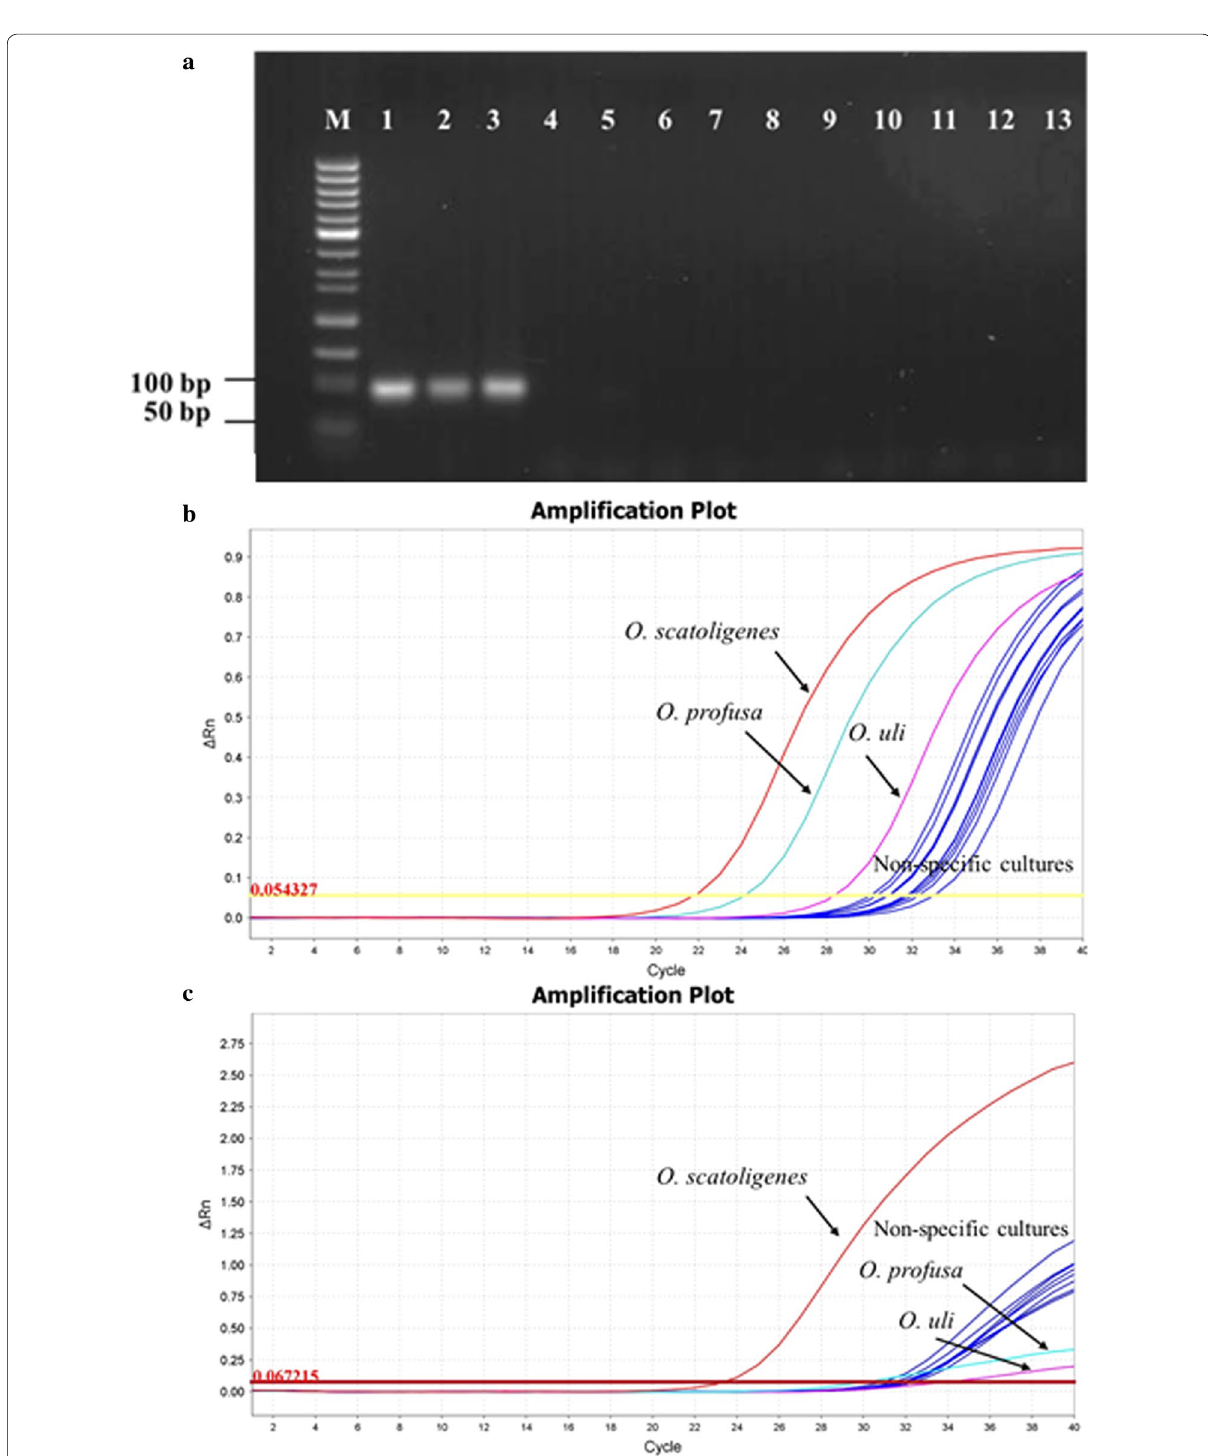
Fig. 2 Specificity of the primer pair alone and TaqMan primer–probe pair for Olsenella scatoligenes SK9K4 T using genomic DNA targeting a specific region of the 16s rRNA gene sequence. a Conventional PCR with the primer pair alone. 1, O. scatoligenes ; 2, O. uli ; 3, O. profusa ; 4–12, non-specific cultures; 13, distilled water. b SYBR Green real-time PCR with the primer pair alone. c TaqMan-MGB real-time PCR with the primer–probe